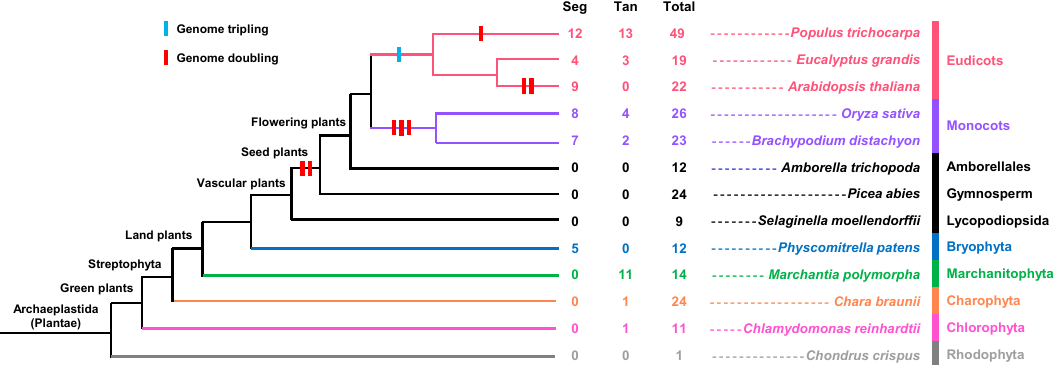
Figure 6. Duplication events of FLA genes in the plant kingdom. The phylogenetic tree on the left was built based on the Tree of Life Web project (available online: http://www.tolweb.org/Green_plants) and whole-genome duplication events in PGDD (available online: http://chibba.pgml.uga.edu/duplication/index/home). The number next to the tree is the number of FLA genes resulting from segmental duplication, tandem duplication, and total FLA genes in the species. Seg: Segmental duplication (pairs); Tan: Tandem duplication (pairs); Total: Total number of FLA genes in the species.